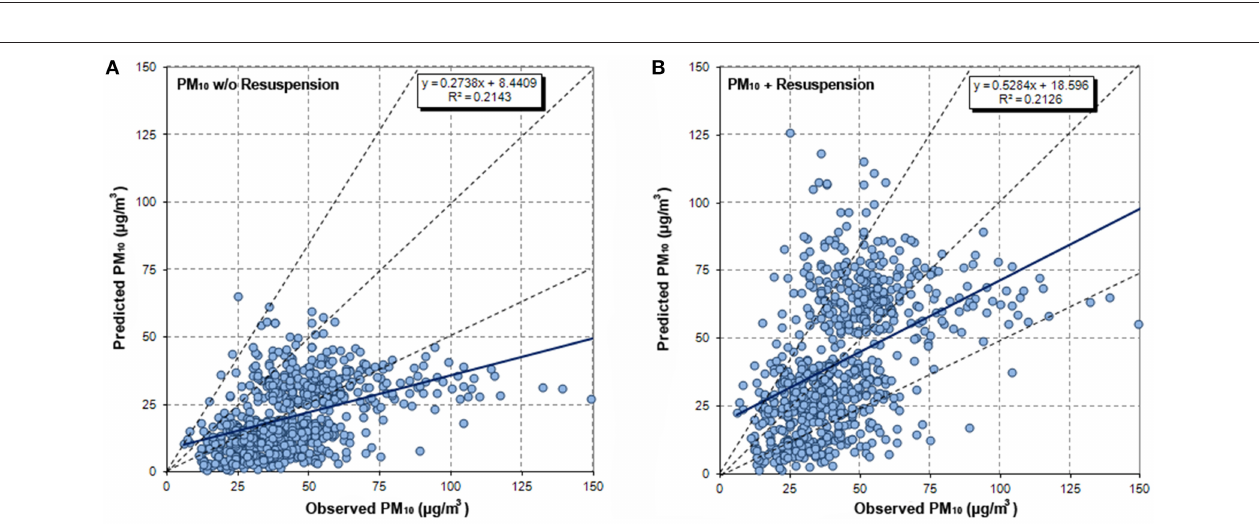
FIGURE 4 | Comparison between hourly OSPM PM 10 predictions and observations in Maldonado site: (A) without resuspension (B) with resuspension.